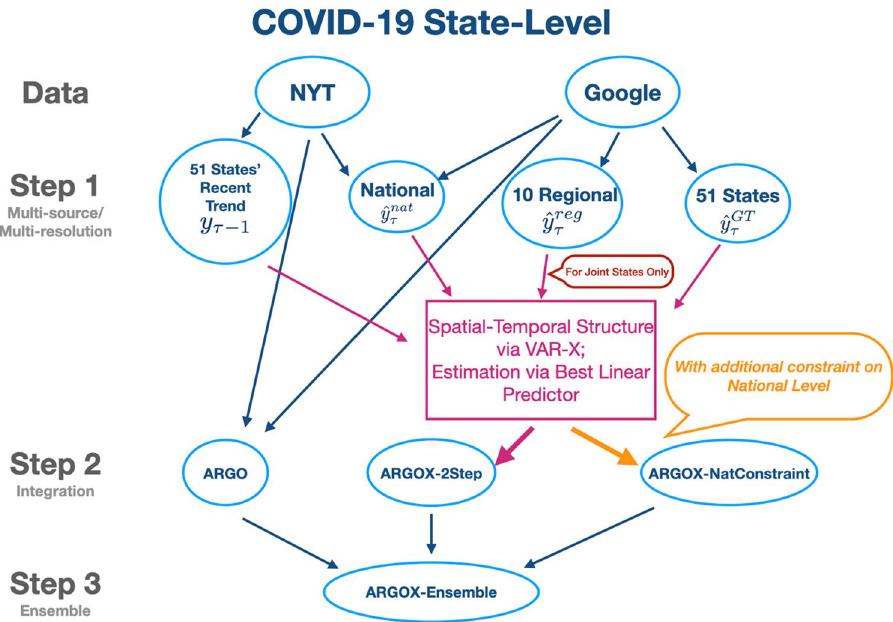
Figure 2. COVID-19 State-Level forecasting methods illustration in flowchart, operated in top-to-bottom fashion. Level 1 shows input data sources being NYT (COVID-19 cases/deaths) and Google search information. Level 2 (step 1) shows different estimations for state-level deaths at week τ . Level 3 (step 2) shows 3 proposed state-level death forecasting methods, each incorporates different information in level 1 and level 2 as inputs. Level 4 (step 3) shows the final state-level forecasting model, ARGOX-Ensemble, which combines the 3 methods in step 2 via winner-takes-all ensemble. For details please see the Methods section, including the VAR-X (vector- autoregressive with exogenous variables)